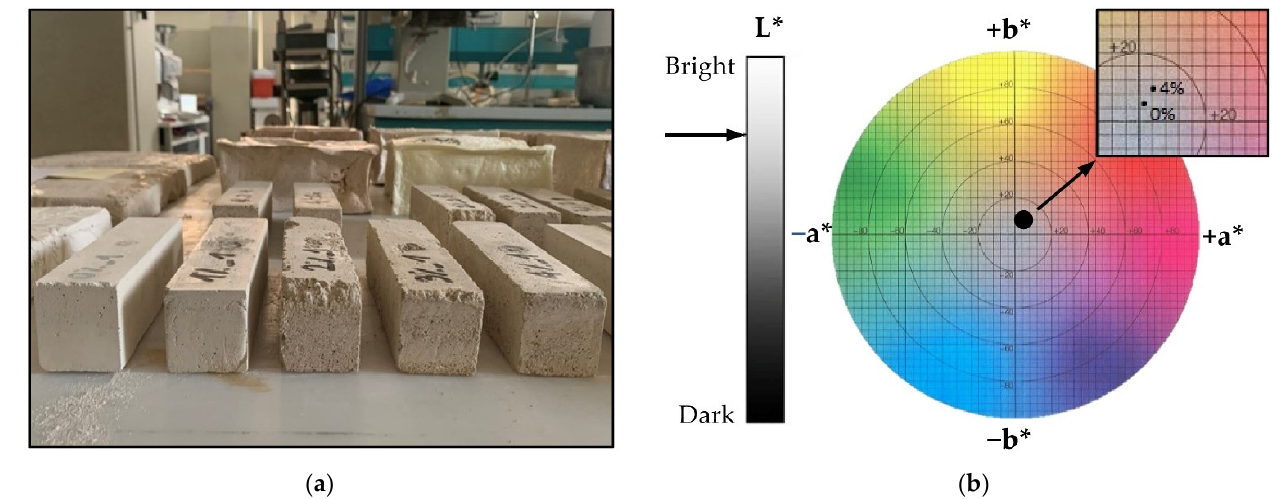
( b ) Figure 4. Optical microscopy images at 8× magnification of mortars containing 0 wt% ( a ) and 4 wt% ( b ) of cork waste. The introduction of increasing cork content involved a color variation in mortars. This phenomenon was visually and macroscopically observed (Figure 5a) and also con- firmed through the colorimeter test (Figure 5b and Table 3). Table 3 shows the results obtained by the colorimetry test in terms of a*, b*, L* values, where: